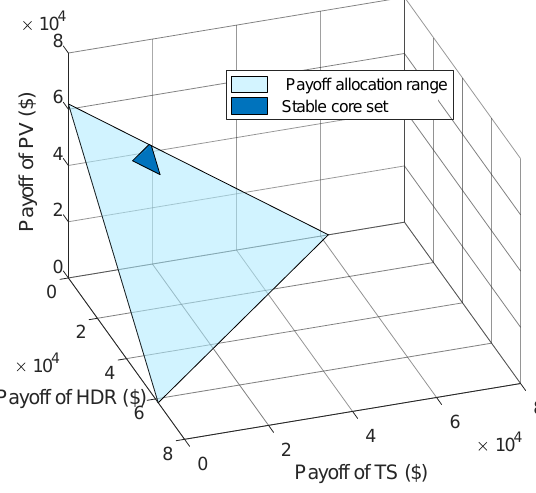
Figure 8. Stable allocation set.